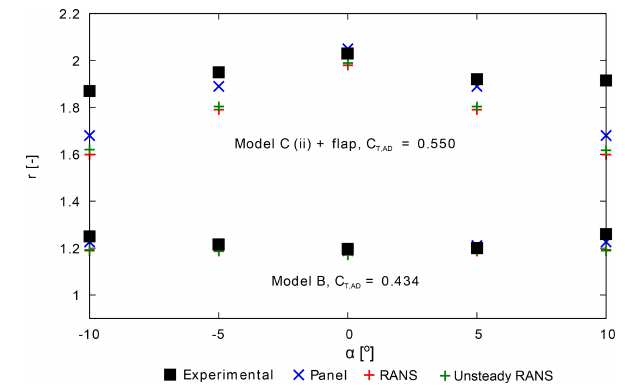
Figure 3. Effect of yawed inflow on the power augmentation factor: comparison between the experiments (Igra, 1977), panel method and RANS method for different duct